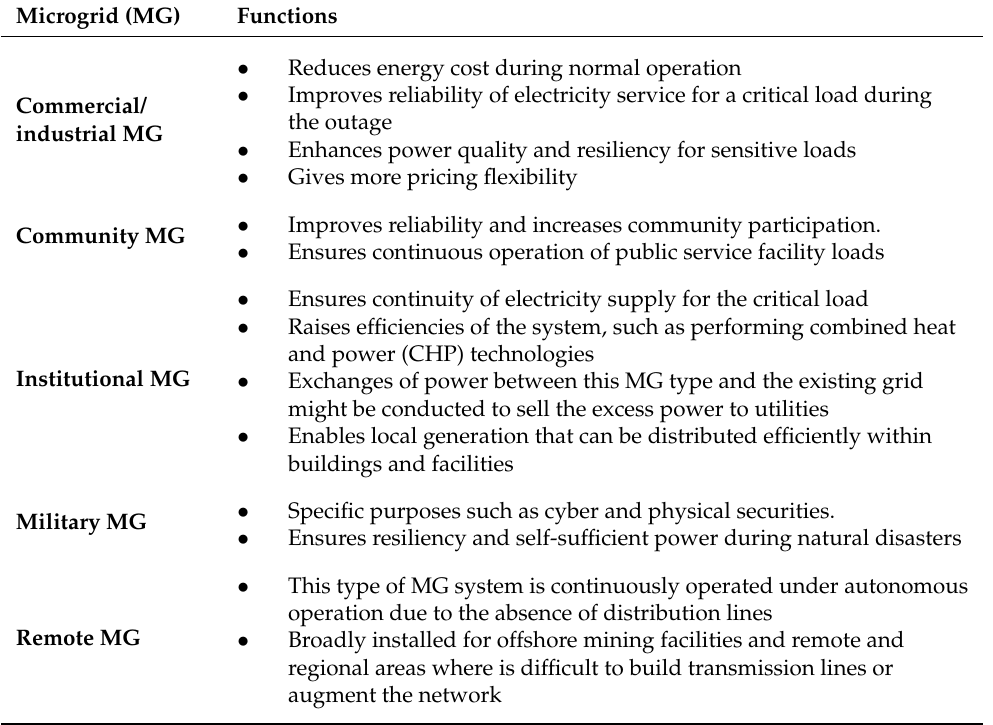
Table 1. MG types and functions